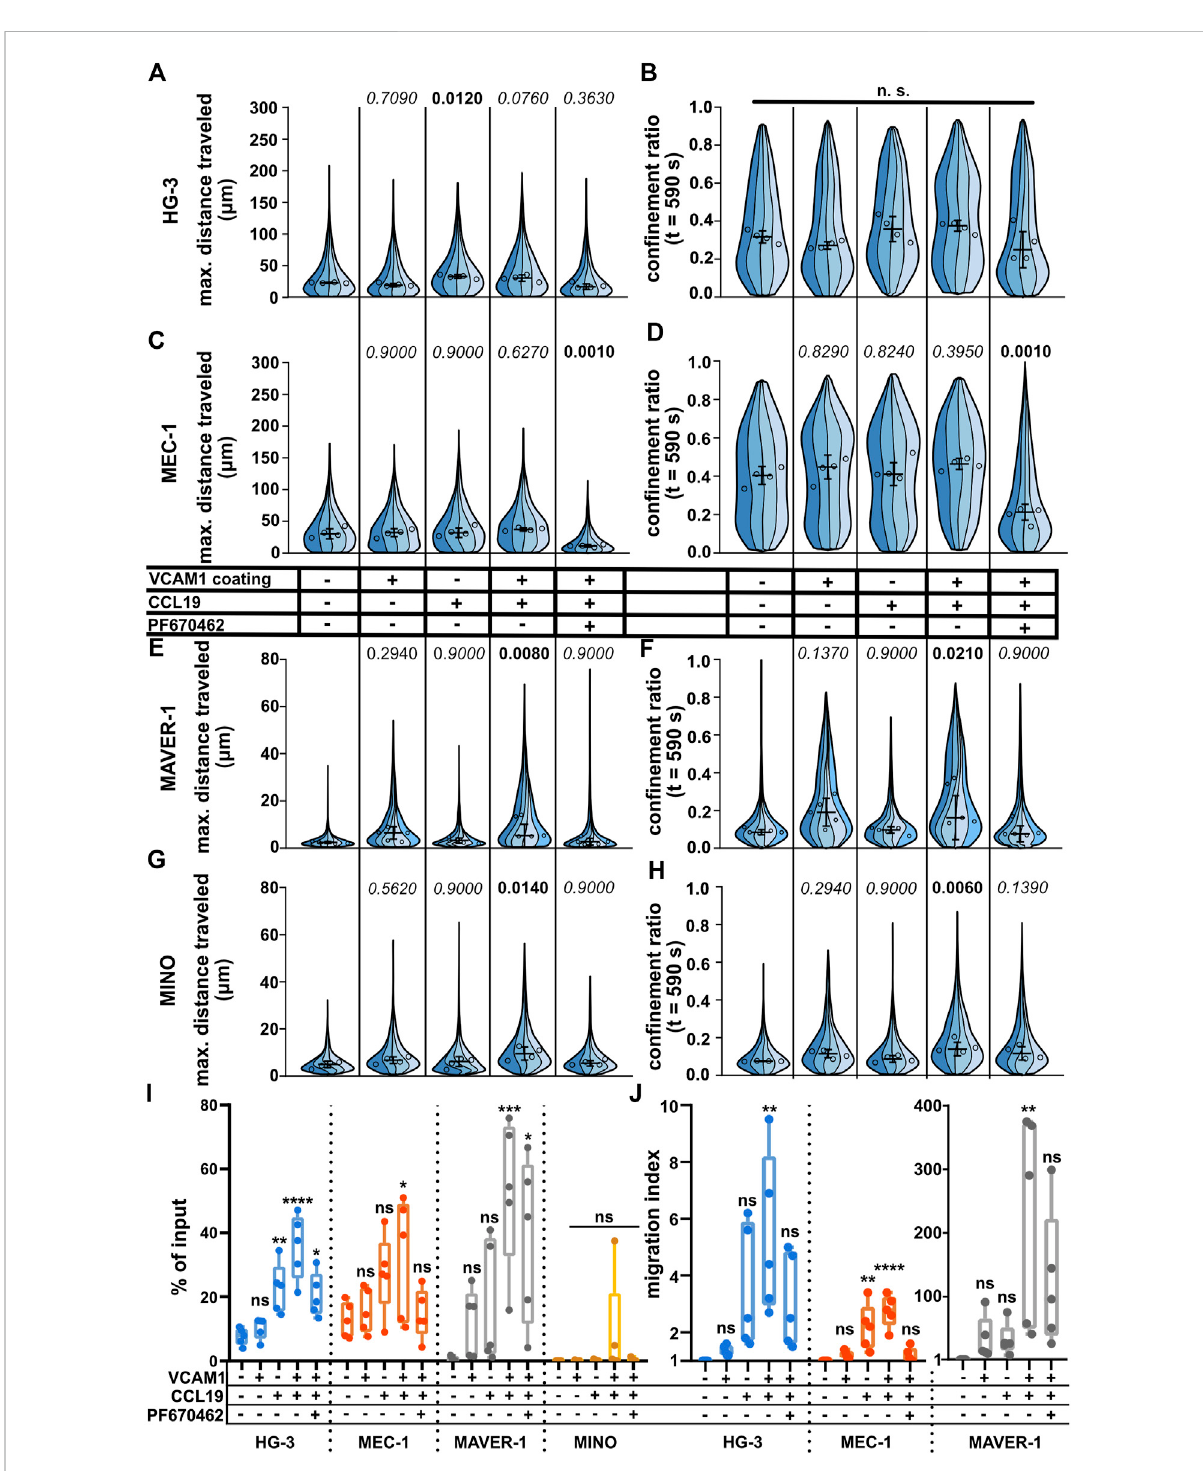
FIGURE 5 Effects of positive stimulation by coating or chemokines on the migration of the tested cell lines. The cells were stimulated by the well surface coatedwith2 μ g/mlVCAM1and/ortreatmentwithCCL19(200 ng/ml)and/or10 μ M.Seetheconditionlegendinthecenterofthe fi gure.Duetothe confounding effects of oscillating cells on “ total distance traveled, ” which are described in detail in the main text, we decided to focus mainly on “ maximum distance traveled ” instead to describe the effects of stimulation more accurately. (A) Maximum distance traveled by HG-3 cells. Statistics:one-wayANOVA, n = 4, p < 0.001, andtheposthoc Tukeytest( p values ofcomparison to unstimulated condition). (B) CR atthelast frame ofthetracking(t=590 s)oftheHG-3cellline(one-wayANOVA,n=4,and p =0.090) (C) MaximumdistancetraveledbyMEC-1cells.Statistics(one-